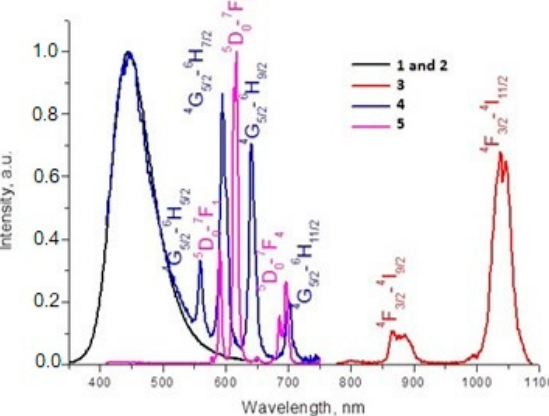
Figure 8. Emission spectra of complexes after excitation at 340